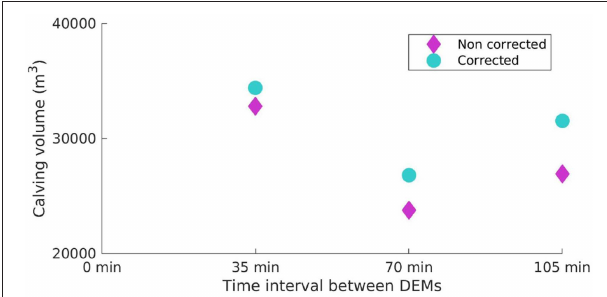
FIGURE 12 | Volume of ice lost by calving obtained by differentiating the DEMs of the second, third, and forth surveys with respect to the first one for the calving event shown on Figures 11a–c . The method was first applied to raw DEMs, and second to DEMs horizontally shifted to compensate the ice